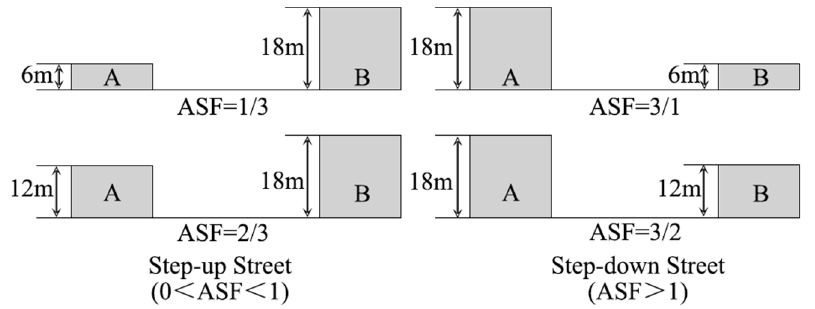
Figure 4. An asymmetric street plan.